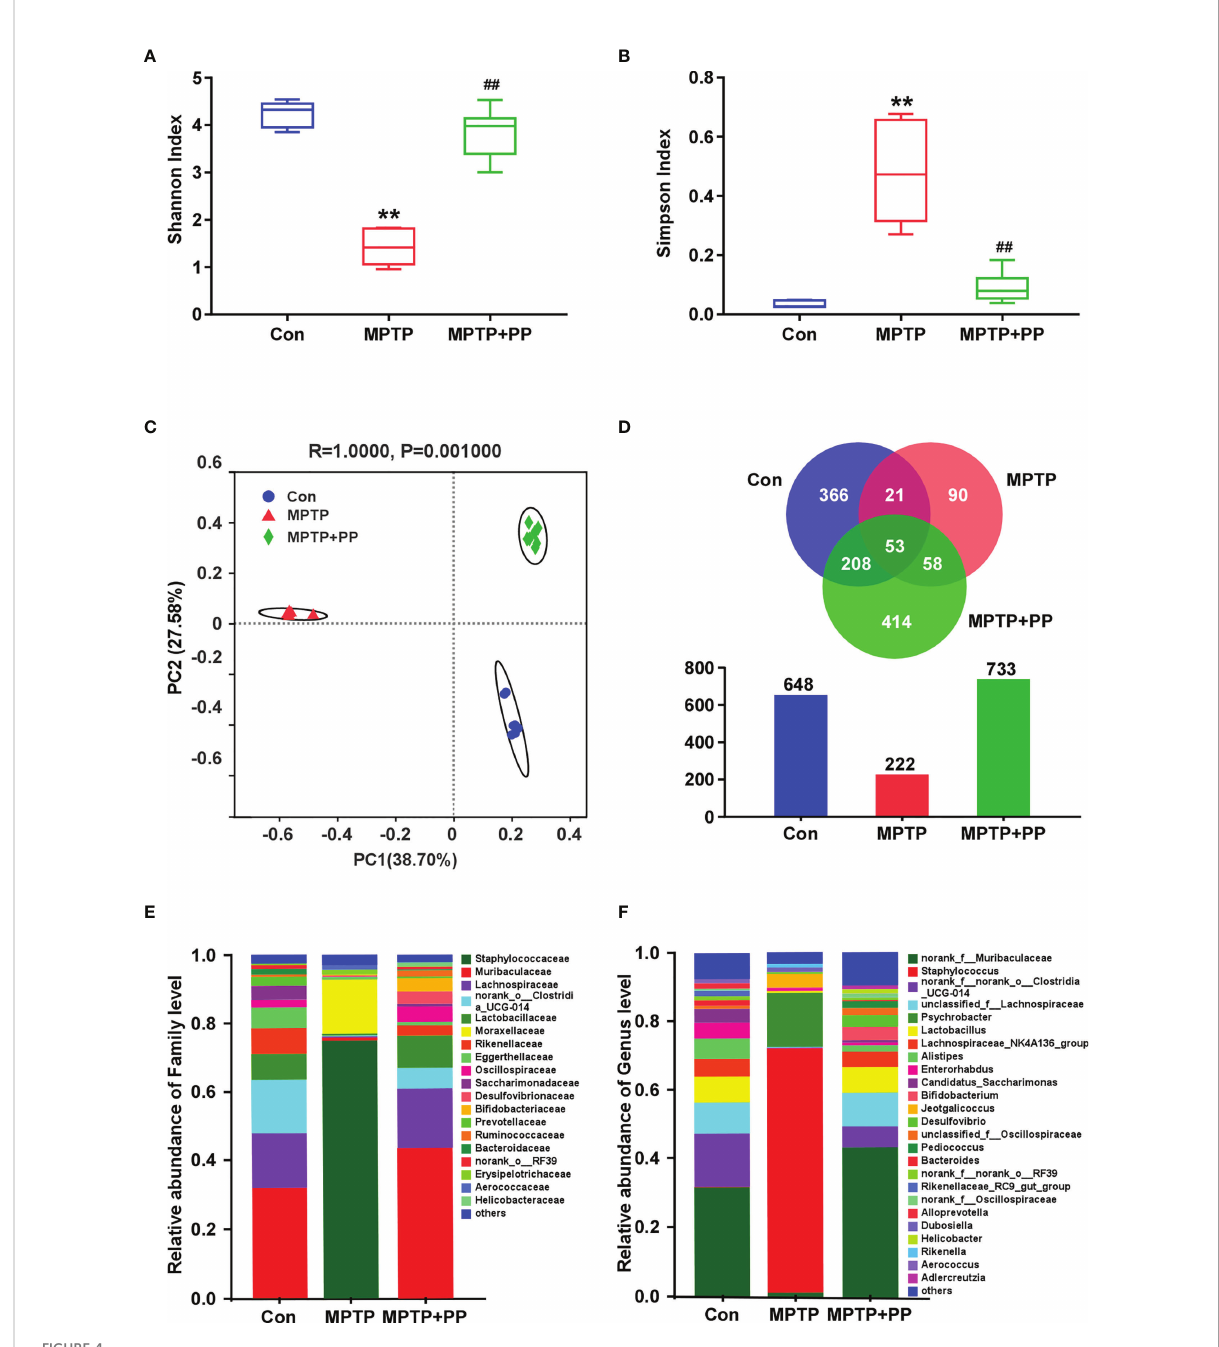
FIGURE 4 Pediococcus pentosaceus treatment reversed the methyl-4-phenyl-1,2,3,6-tetrahydropyridine (MPTP)-induced abnormal microbiota composition. (A) Shannon index of gut microbial diversity. (B) Simpson index of gut microbial diversity. (C) Principal coordinate analysis plots of gut microbial diversity. (D) Venn diagram and quantitative analysis of microbial community composition among three groups. (E) Relative abundance of gut microbiota at the family level among three groups. (F) Relative abundance of gut microbiota at the genus level among three groups. Statistical comparison by Kruskal – Wallis rank sum test with post-hoc comparisons of Tukey – Kramer. Data are presented as median + interquartile range. ** P < 0.01 vs . Con group, ## P < 0.01 vs . MPTP